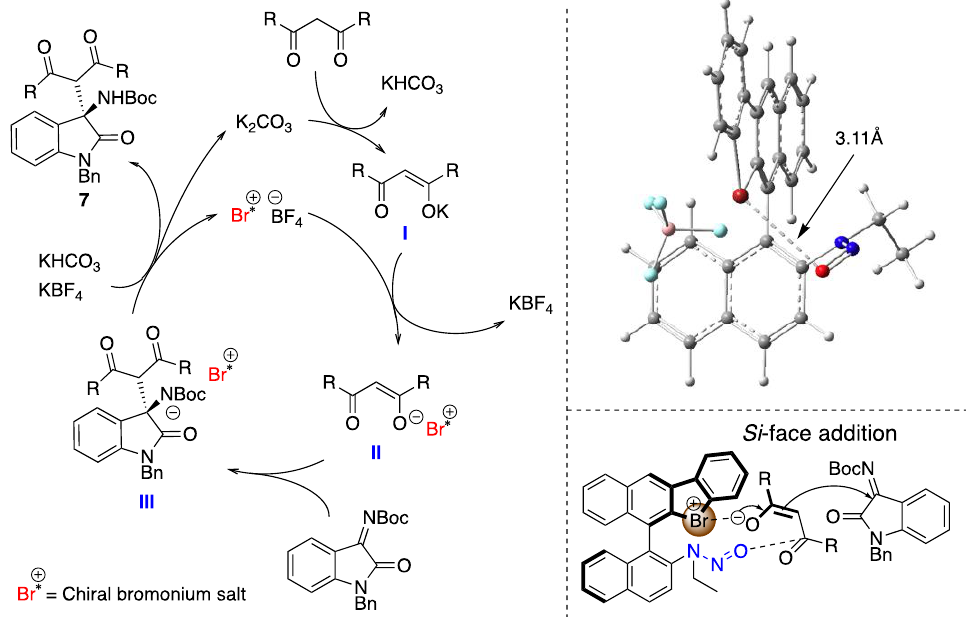
Figure 7. Plausible reaction mechanism ( left ), the DFT-calculated optimized structure of 4a (M06- 2X/6-31G(d)) generated by GaussView 6 ( right , upper), and the plausible transition state structure ( right , lower). The Br···O distance of the calculated structure is 3.11 Å .